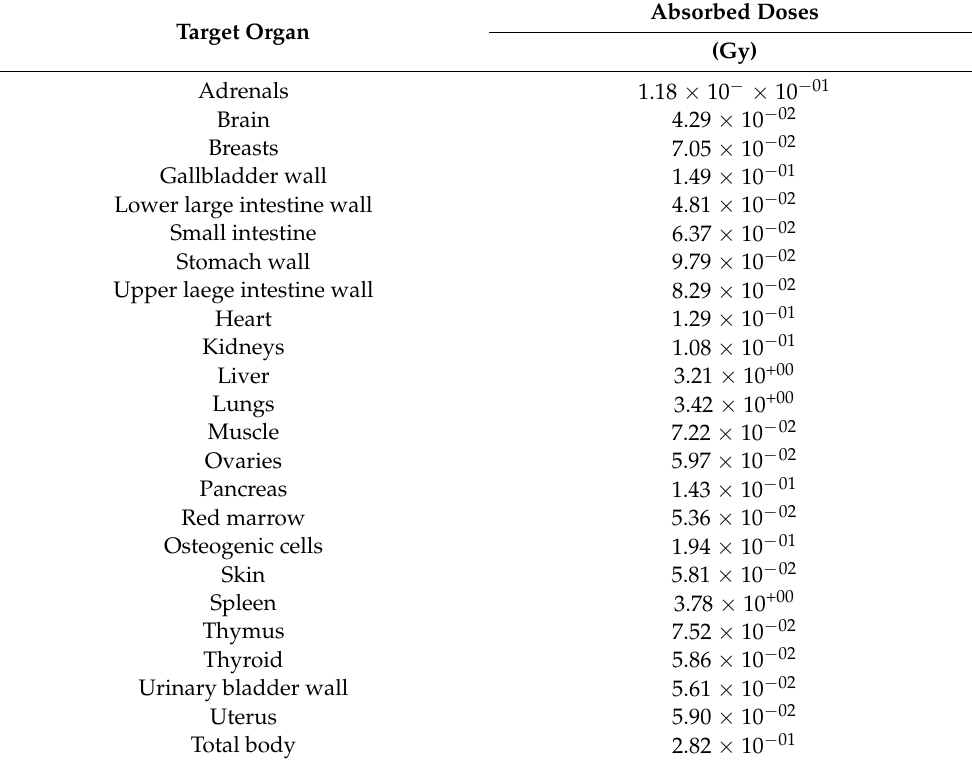
Table 9. Radiation absorbed doses (Gy per 1350 MBq) of 177 Lu 2 O 3 -iPSMA nanoparticles, calculated from a patient with multiple colorectal liver